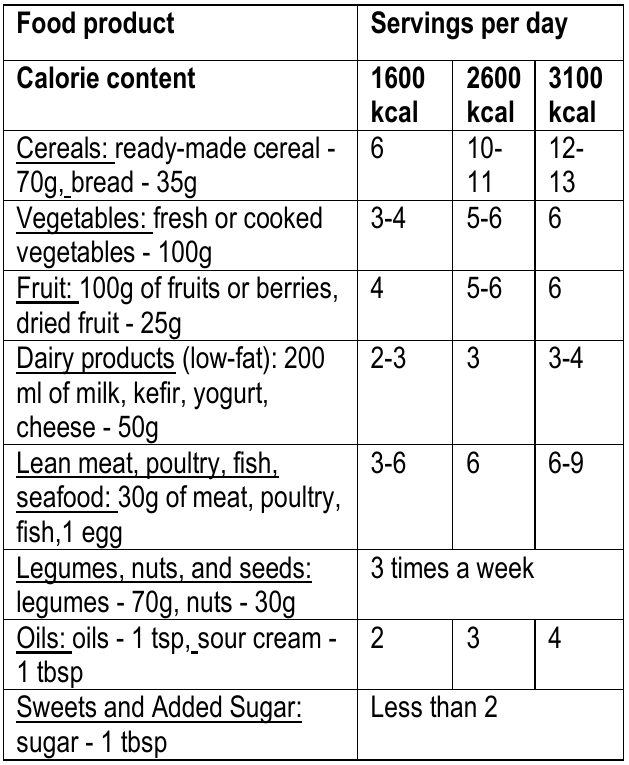
Table 1. Food products included in the daily